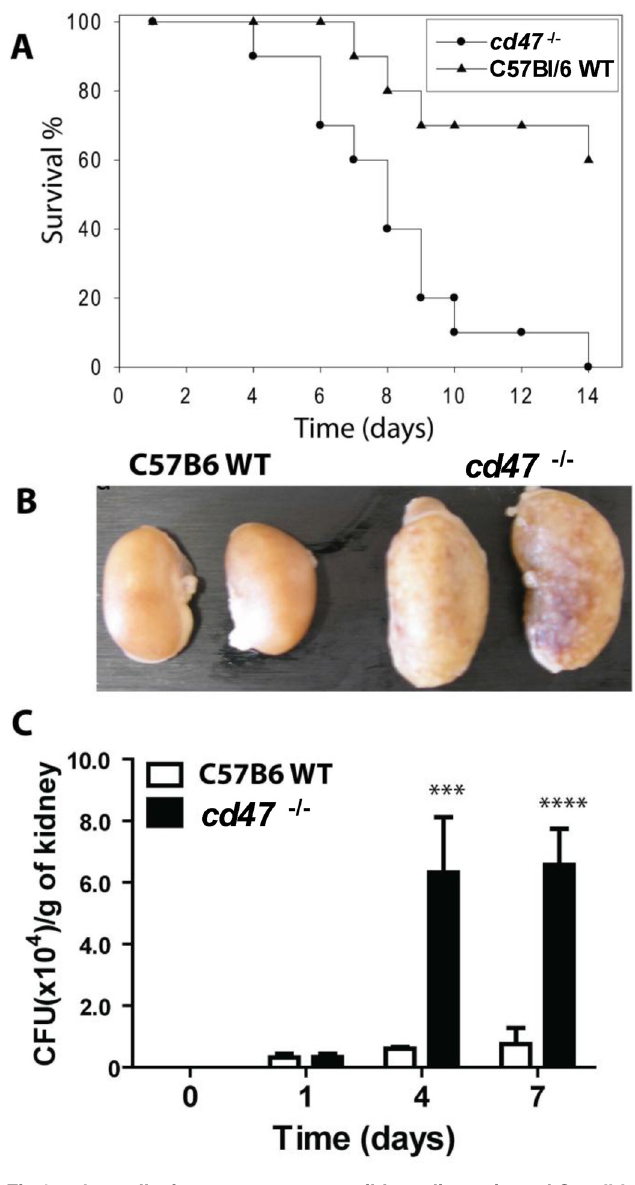
Fig 1. cd47 -null mice are more susceptible to disseminated Candida infection. (A) . Each group consisted of fifteen 8 – 12 week old female mice. Mice were administered 5x10 5 cells through the lateral tail vein. Results were analyzed using log-rank (Mantel-Cox) test and Jehan-Breslow-Wilcoxon test. (B). Kidneys of mice infected with C . albicans . WT mice did not show gross lesions, whereas CD47 null mice showed enlarged mottled kidneys with superficial micro-abscesses. (C). Kidney fungal burdens of mice infected with C . albicans SC5314 strain. Solid bars represent mean CFU of infected left kidney homogenates of cd47 -/- mice determined by CFU on BiGGY agar from six representative serial dilutions from each kidney, representing five mice per time point infected. Open bars represent mean ± SE, n = 3, for WT mice infected with C . albicans and were analyzed using two-way ANOVA with post Bonferroni comparison test. interval 2.1 – 23.4, P < 0.001, Fig 1A). cd47 -/- mice inoculated with C . albicans died as early as 4 day post-infection (PI) and suffered 100% mortality by 14 days PI. Infected WT mice did not die until 7 day PI, and 60% survived at the end of the experiment on day 14 PI. Control mice administered with intravenous saline alone had no mortality (data not shown).